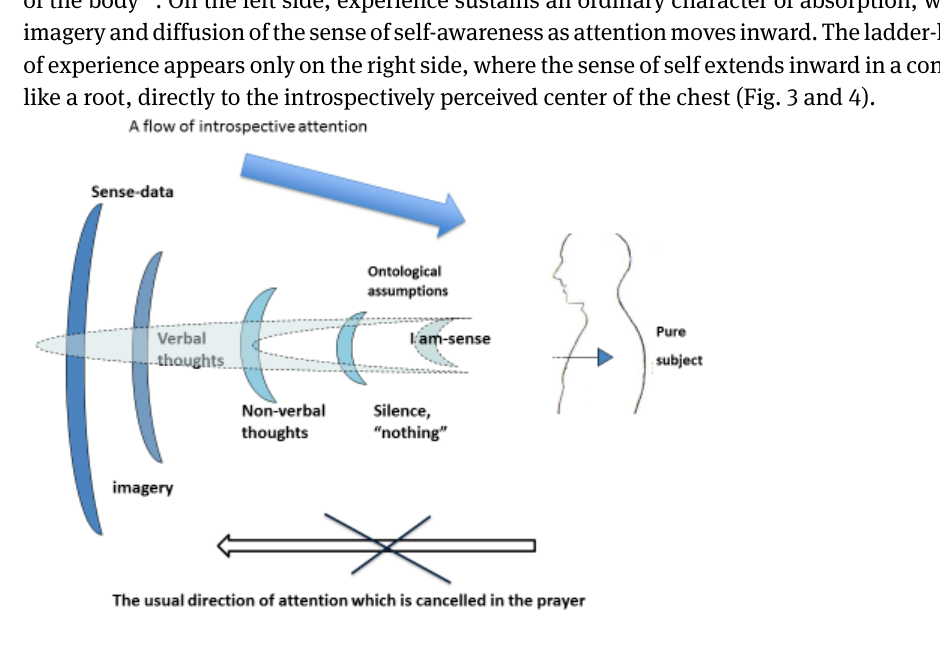
Figure 4. Constitution of the introspective somatic self-awareness in the process of the “purest” Prayer of the Heart on the right side of the